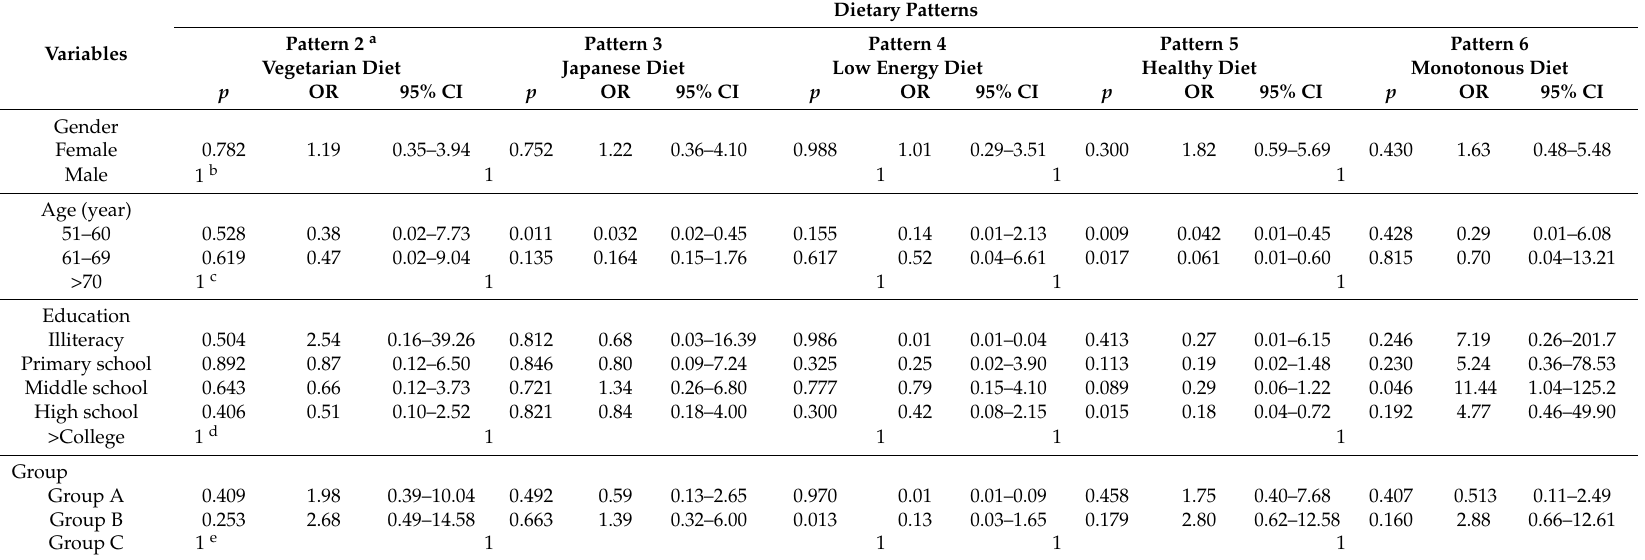
Table 6. Analysis of the associations between different dietary patterns and